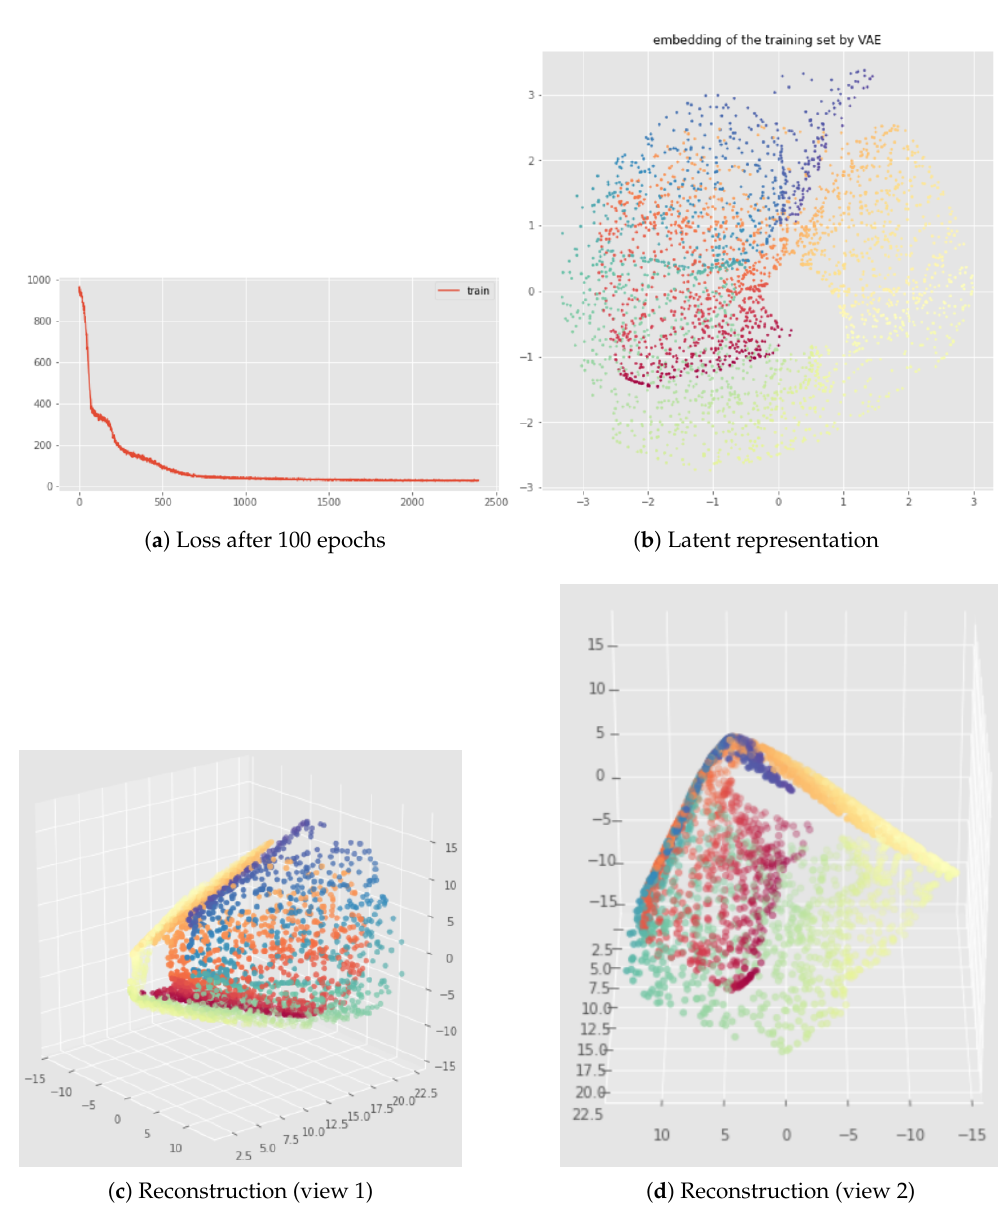
Figure 21. Witness Simplicial VAE applied to the swissroll after 100 epoch: loss ( a ), latent representa- tion of the training set ( b ), and reconstruction of the training set ( c , d ) from different views. Hyper parameters: batch size = 128, pytorchseed = 1, 32 landmarks, r filtration = 6, weights w SE = w SD =